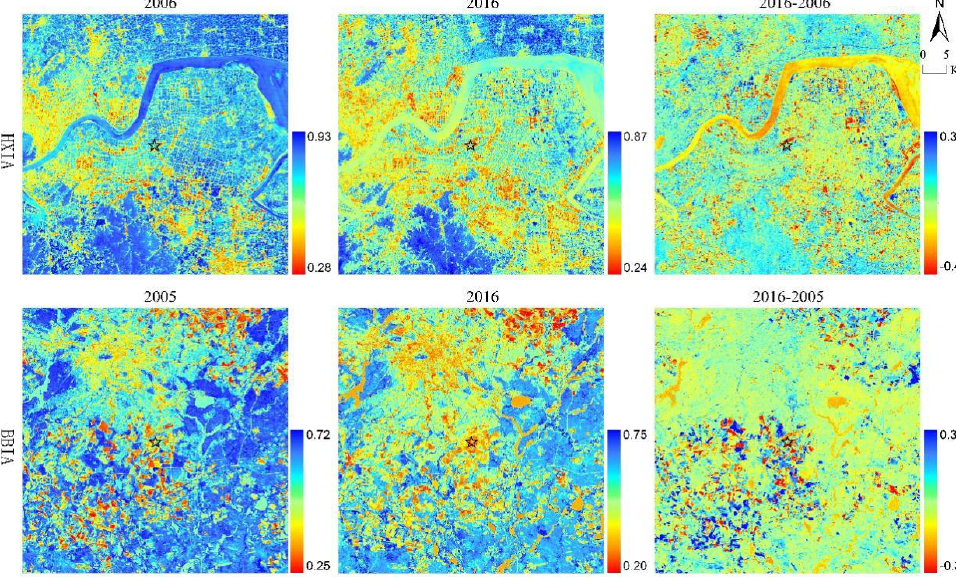
Figure 4. RSEI difference distribution in the case study areas of the two airports.